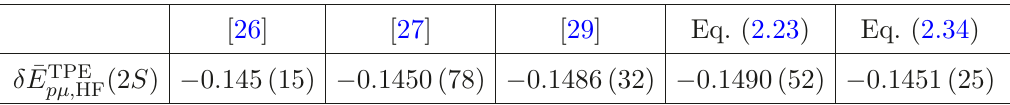
Table 3 . Different predictions for δ ¯ E TPE (2 S ) in meV. δ ¯ E TPE (1 S ) can trivially be obtained pµ, HF pµ, HF by multiplying them by 2 3 . The coefficient ¯ c pµ 4 can be obtained by multiplying them by the , TPE 2 πm 2 p factor = 312 . 124 meV − 1 . The first three numbers refer to values obtained using experimental m 3 r α 5 information of the Sachs form factors and dispersion relations. The fourth is from the measurement of the 2S hyperfine splitting in muonic hydrogen. The fifth is the prediction from chiral perturbation theory and the hydrogen hyperfine